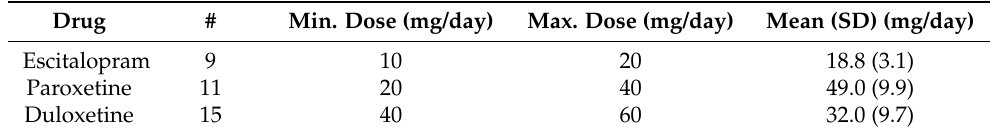
Table 2. Drugs and daily dose of the